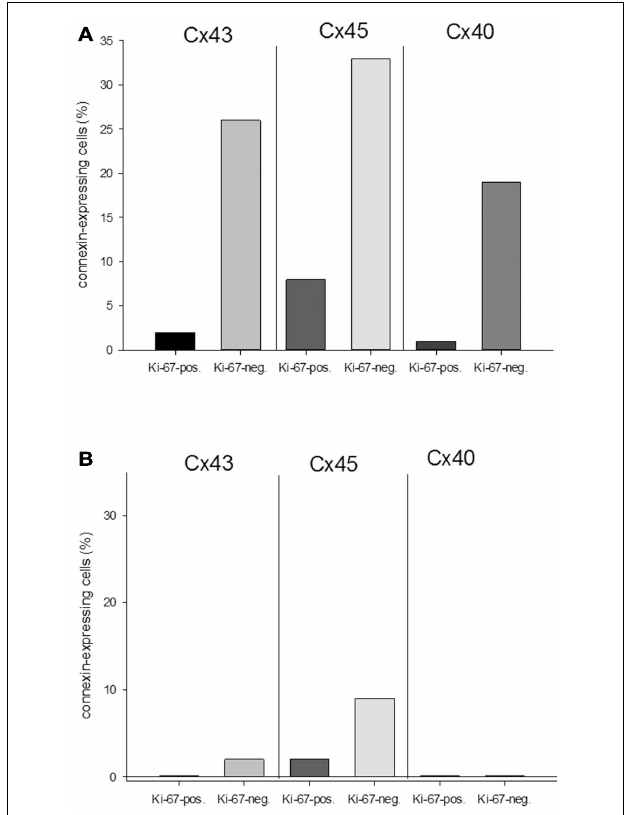
FIGURE 6 | Quantitative analysis of the relationship between connexin expression and the proliferation marker Ki-67 in the middle of the tumor (A) and at the tumor-heart border